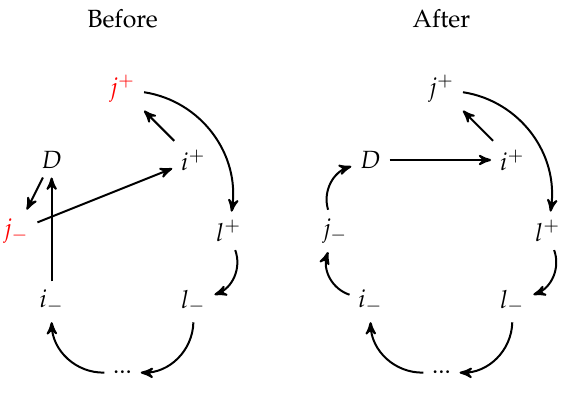
Figure 1. Repair-Destroy Relocate